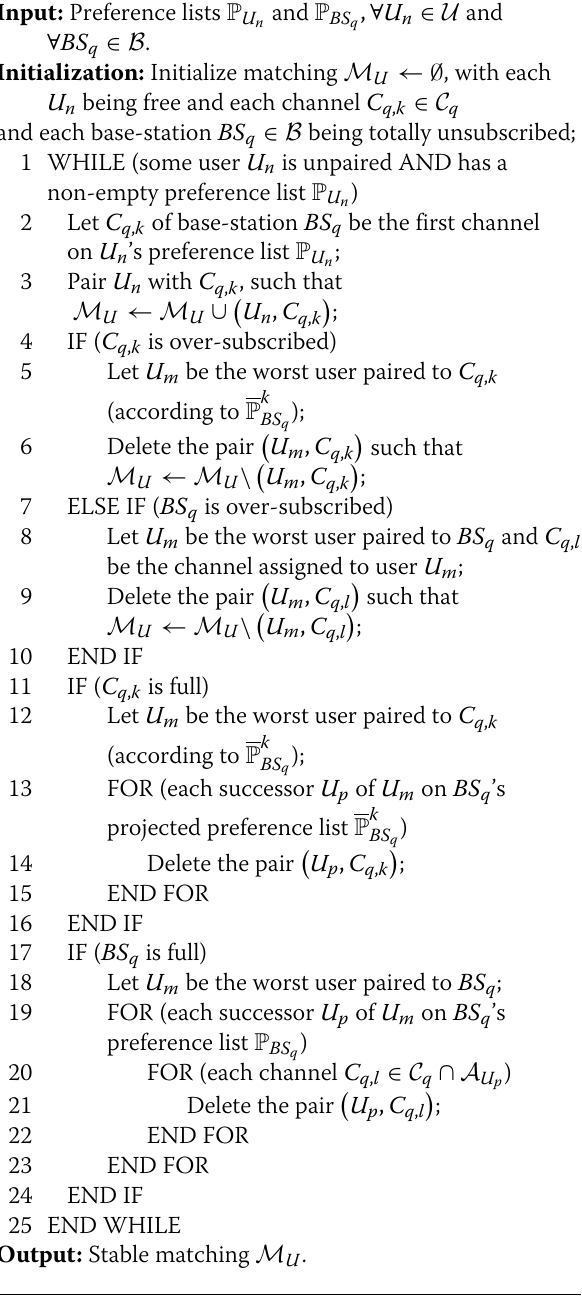
Algorithm 2 Users-Oriented Stable Matching